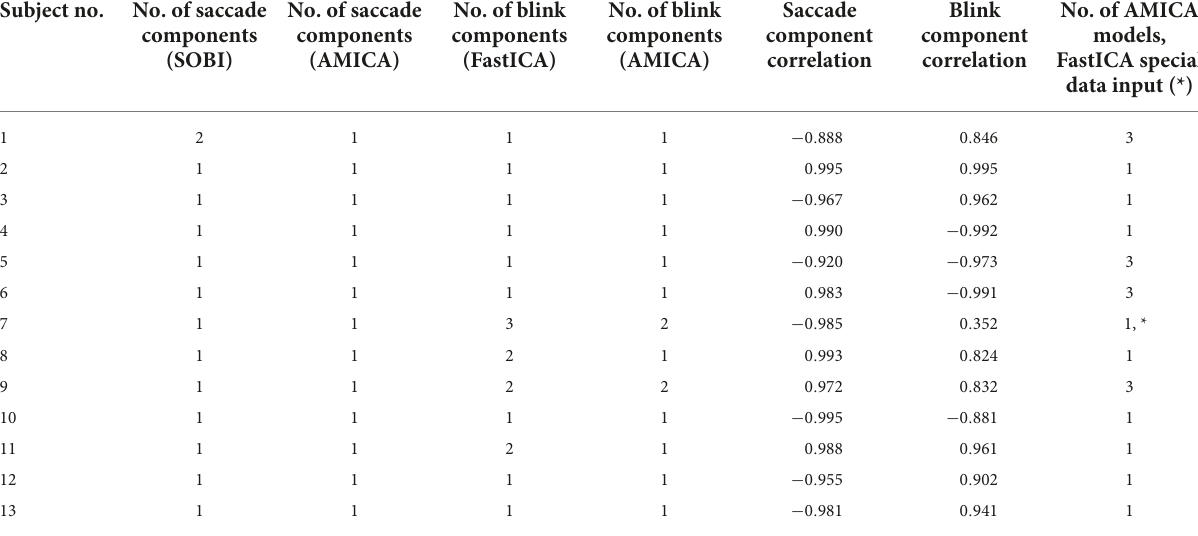
TABLE 1 Number of components required by SOBI-FastICA and AMICA to extract saccade and blink artifacts and the Pearson correlations between the components extracted by the different methods, per artifact type. Subject